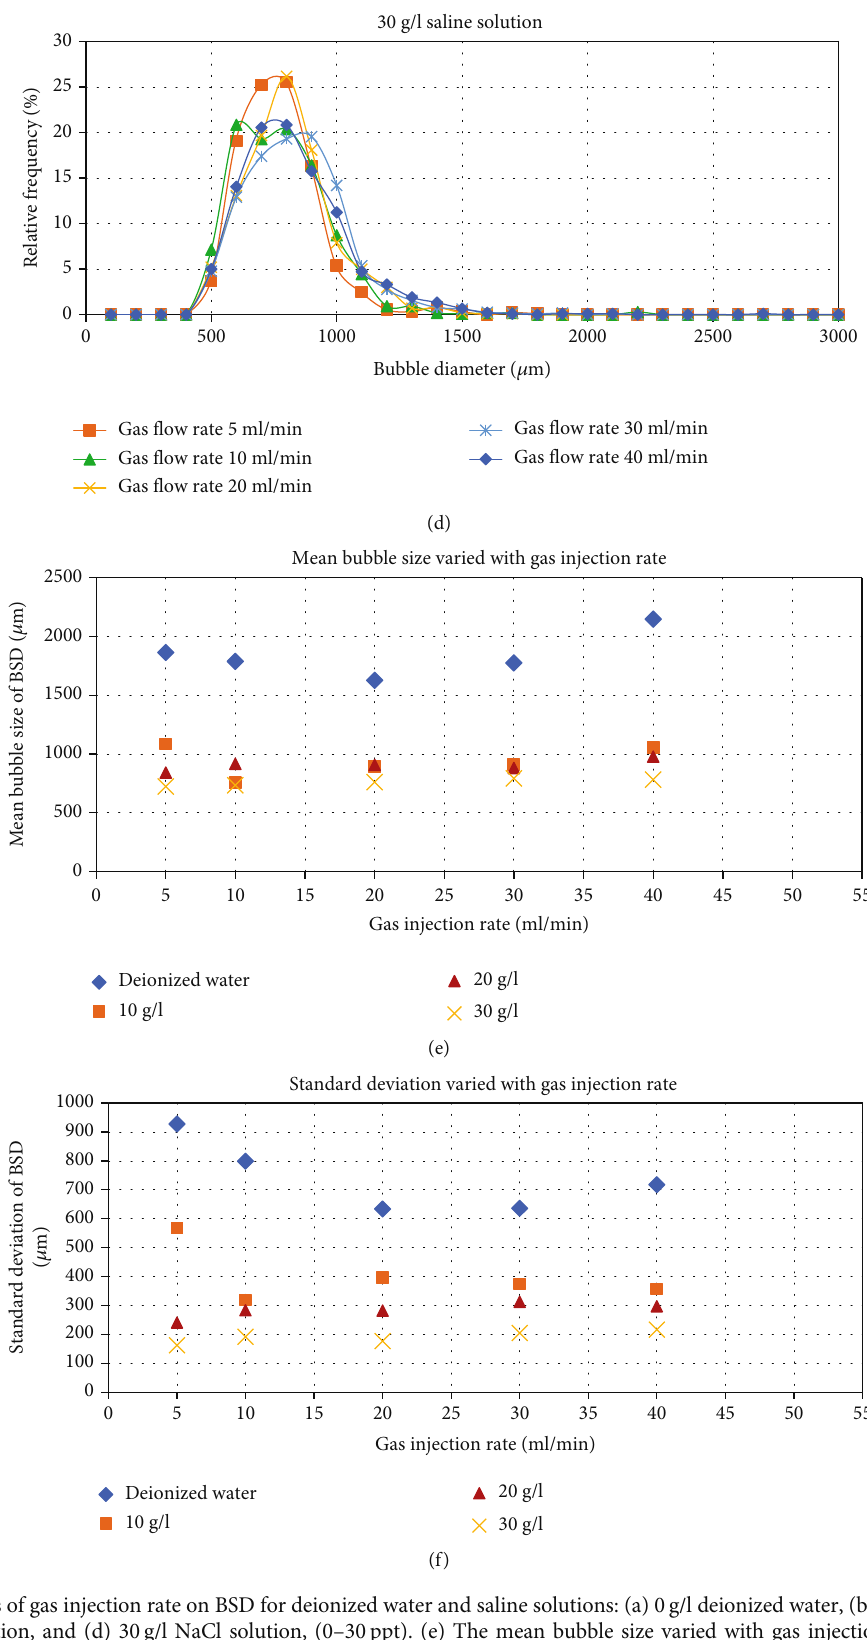
Figure 9: The e ff ects of gas injection rate on BSD for deionized water and saline solutions: (a) 0g/l deionized water, (b) 10 g/l NaCl solution, (c) 20 g/l NaCl solution, and (d) 30 g/l NaCl solution, (0 – 30ppt). (e) The mean bubble size varied with gas injection rates. (f) The STD varied with gas injection